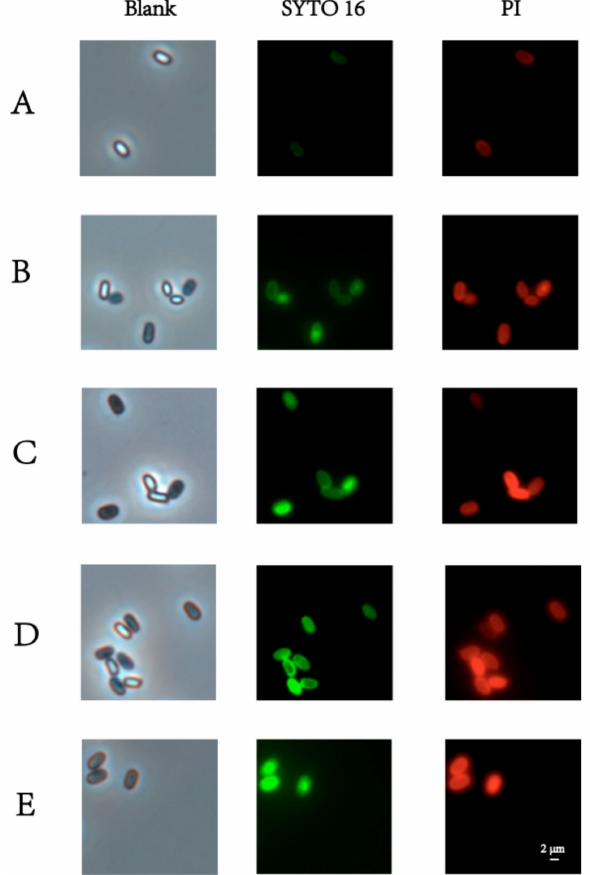
Figure 3. Phase-contrast and fluorescence microscope images of ( A ) untreated spores and spores treated with ( B ) 200 MPa for 15 min, ( C ) 80 ◦ C for 15 min, ( D ) LK at 25 ◦ C for 15 min, and ( E ) 200 MPa at 80 ◦ C combined with LK for 15 min. The concentration of LK was 10 2 µ